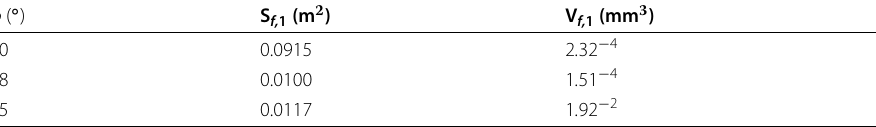
Table 3 Sensitivity analysis on friction angle